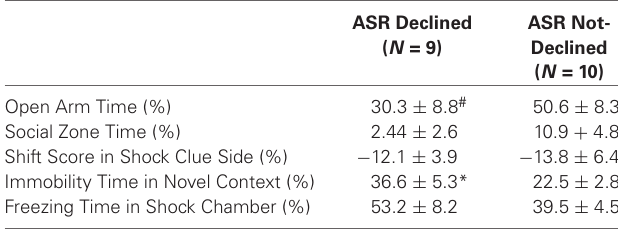
Table 1 | PTSD-like behaviors in ASR Declined and Not-Declined subjects (according to ASR in 1 h).